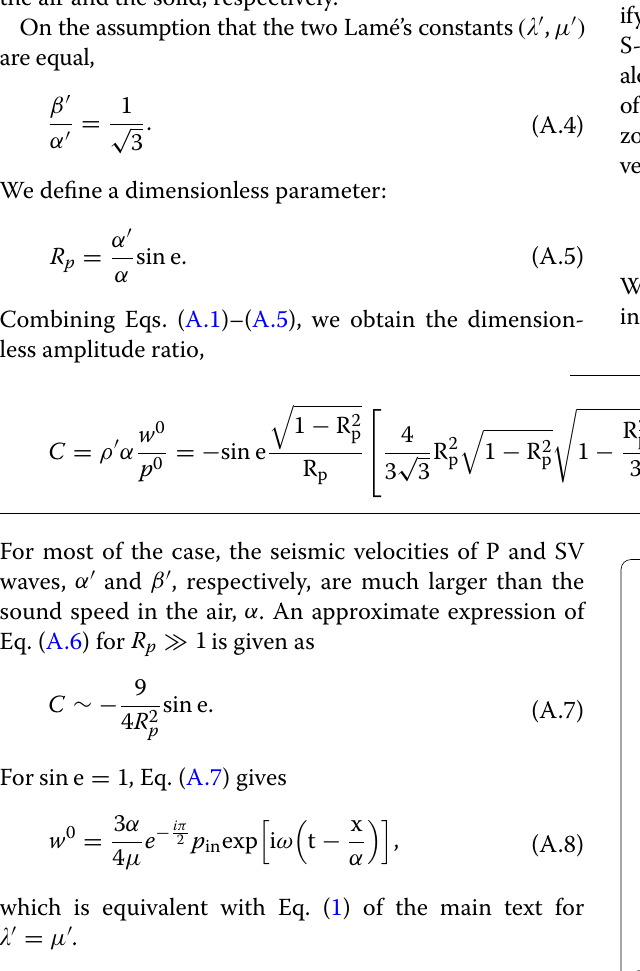
Fig. 7 The absolute value of C vs. R p in the case of sine